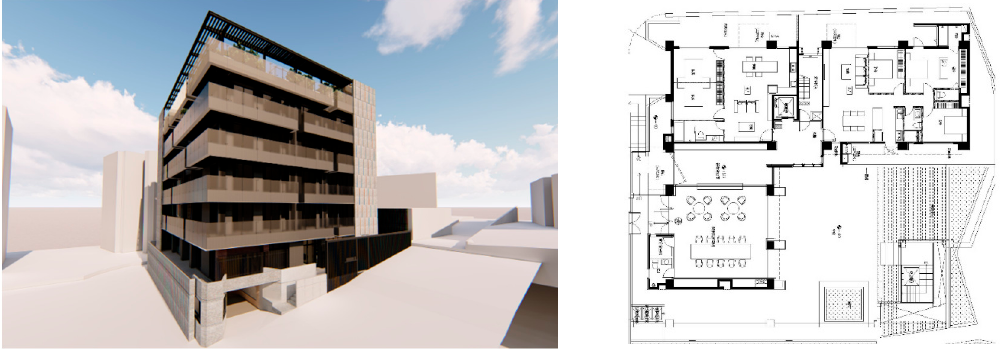
Figure 1. 3D model of the project.